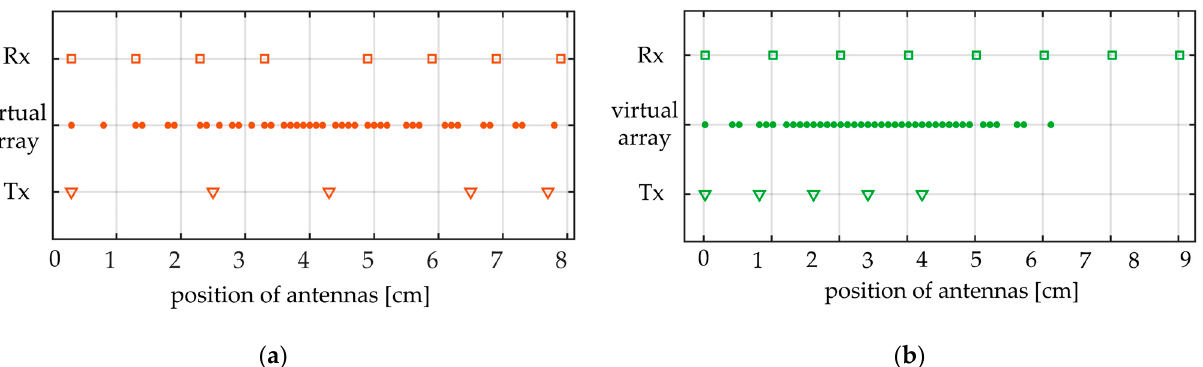
Figure 2. Positions of real Tx, Rx, and virtual antenna arrays: ( a ) for the CS array; ( b ) for the non-uniform array.